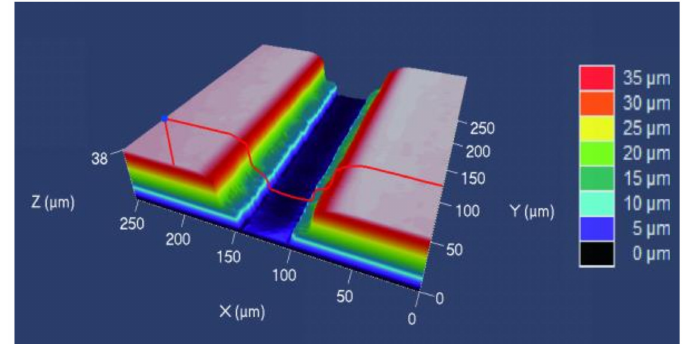
Figure 5. The laser confocal micrograph of the microchannel.